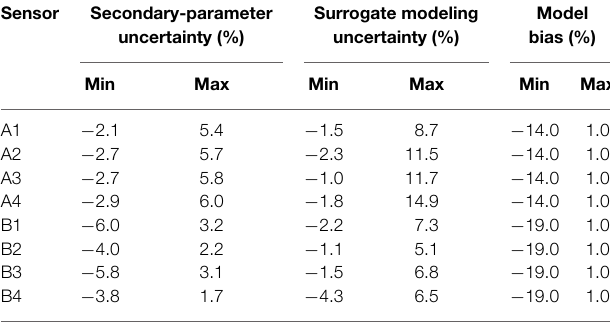
TABLE 2 | Secondary parametric uncertainty, surrogate modeling uncertainty, and model bias at each sensor location.